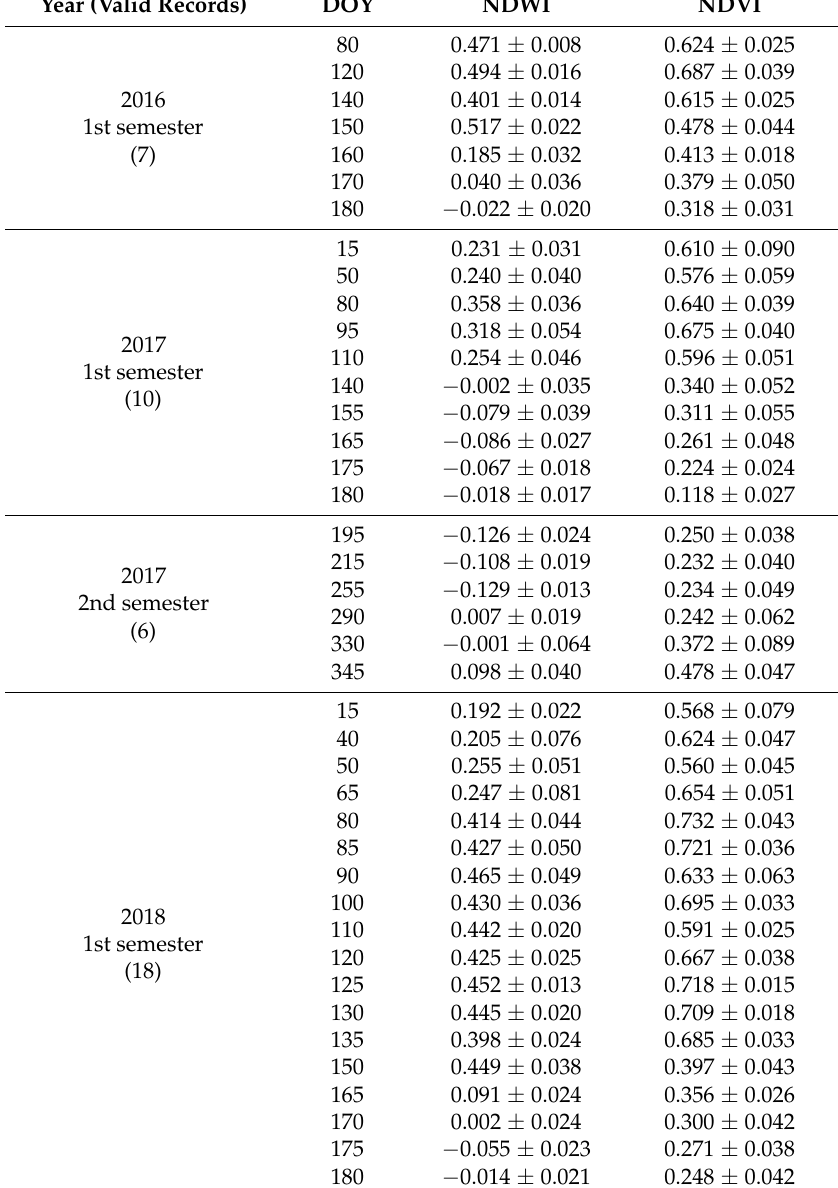
Table 3. Descriptive statistics (mean ± standard deviation) of NDWI and NDVI captured at the 12 sampling points of the studied field, for each sampling date, between January and June 2016